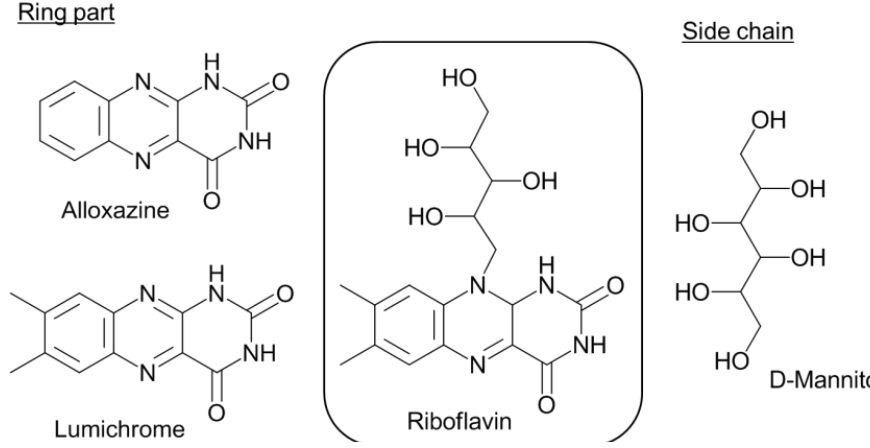
Figure 10. Riboflavin and related